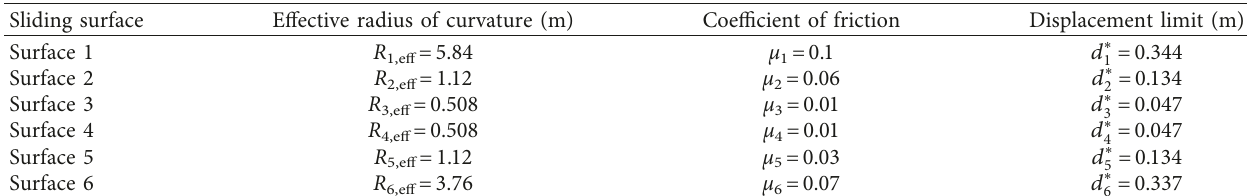
Table 3: Design parameters for the QFPB isolated squat tank.